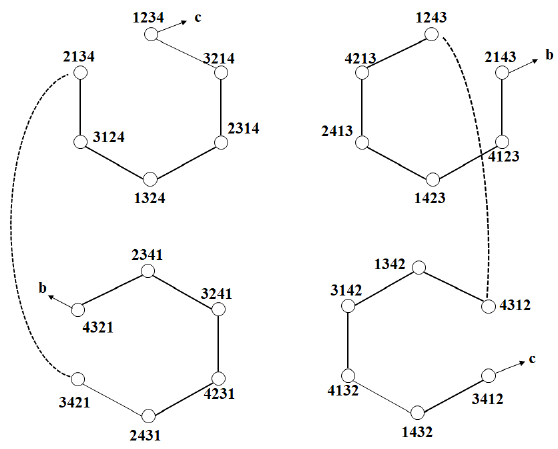
Figure 4. Hamiltonian cycle in LS 4 .